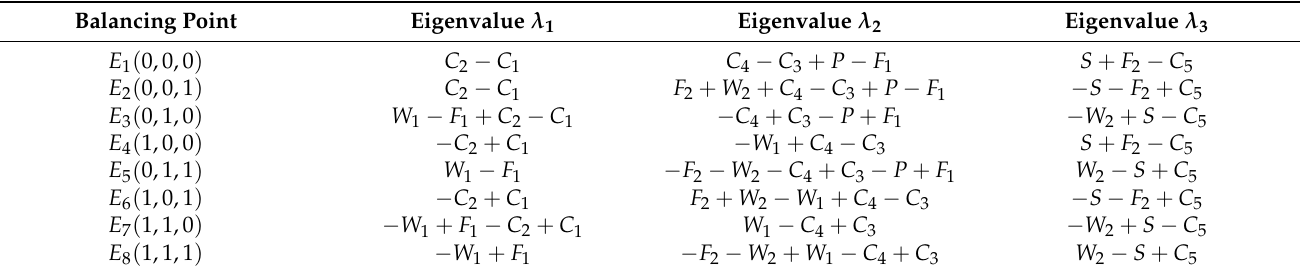
Table 8. System equilibrium points and their characteristic